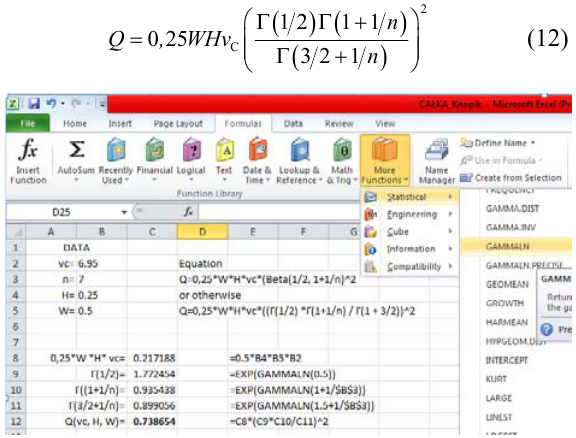
Fig. 8 . Solution of the equation (10) using Excel The numerical value of the flow rate Q from the equa- tion (12) was determined by using Microsoft Excel spreadsheet ( Fig. 8